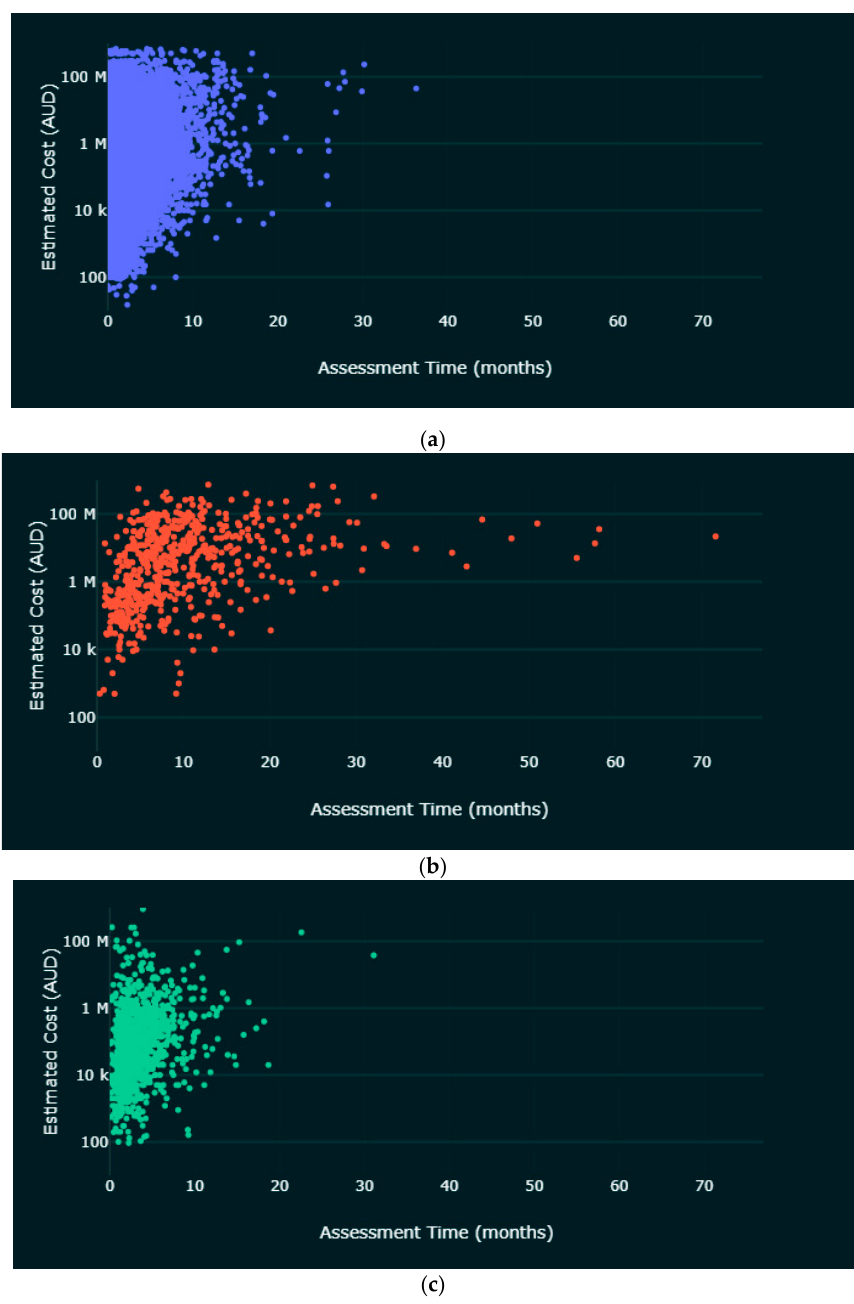
Figure 43. Estimated cost vs. assessment time for all determined DAs (log scale) (2004–2022): ( a ) Approved with conditions (each purple dot represents a DA that is approved with conditions) ( b ) Deferred commencement (each red dot represents a DA with deferred commencement determina- tion) ( c ) Refused (each green dot represents a DA that is